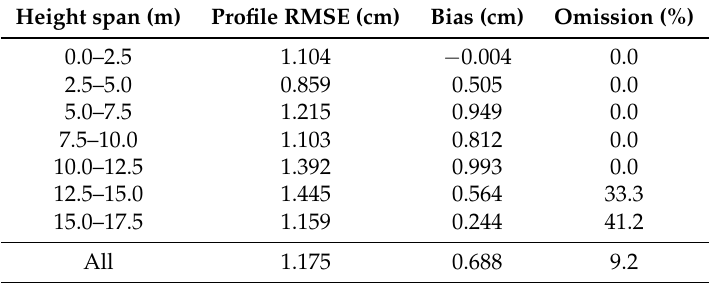
Table 8. Stem profile diameter RMSE and omission errors for different height spans of the pine trees at the Svartberget test site. The parameter settings used in the stem profile detection method were: voxel size of 3 cm, curvature weight of 0.75 and cluster weight of 15. The total number of manually-calipered stem profile diameters is 153.